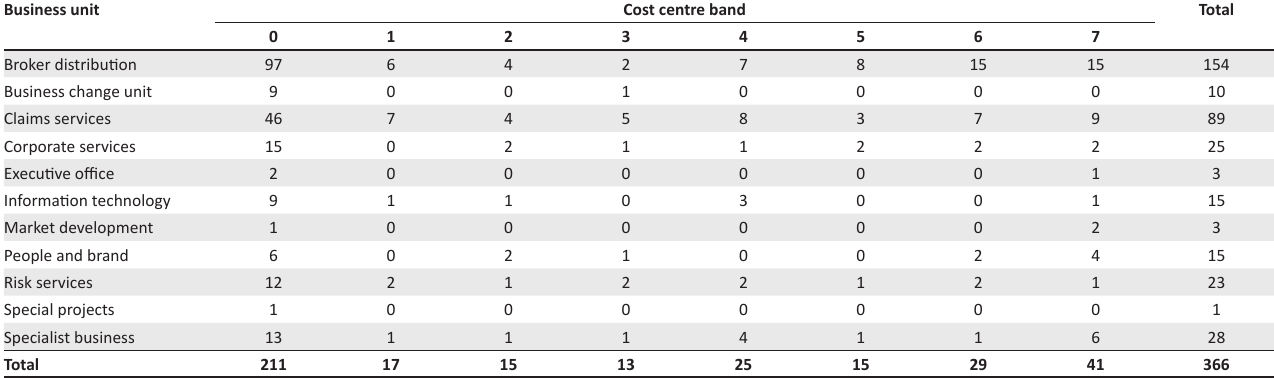
TABLE 11: Cost centre band and